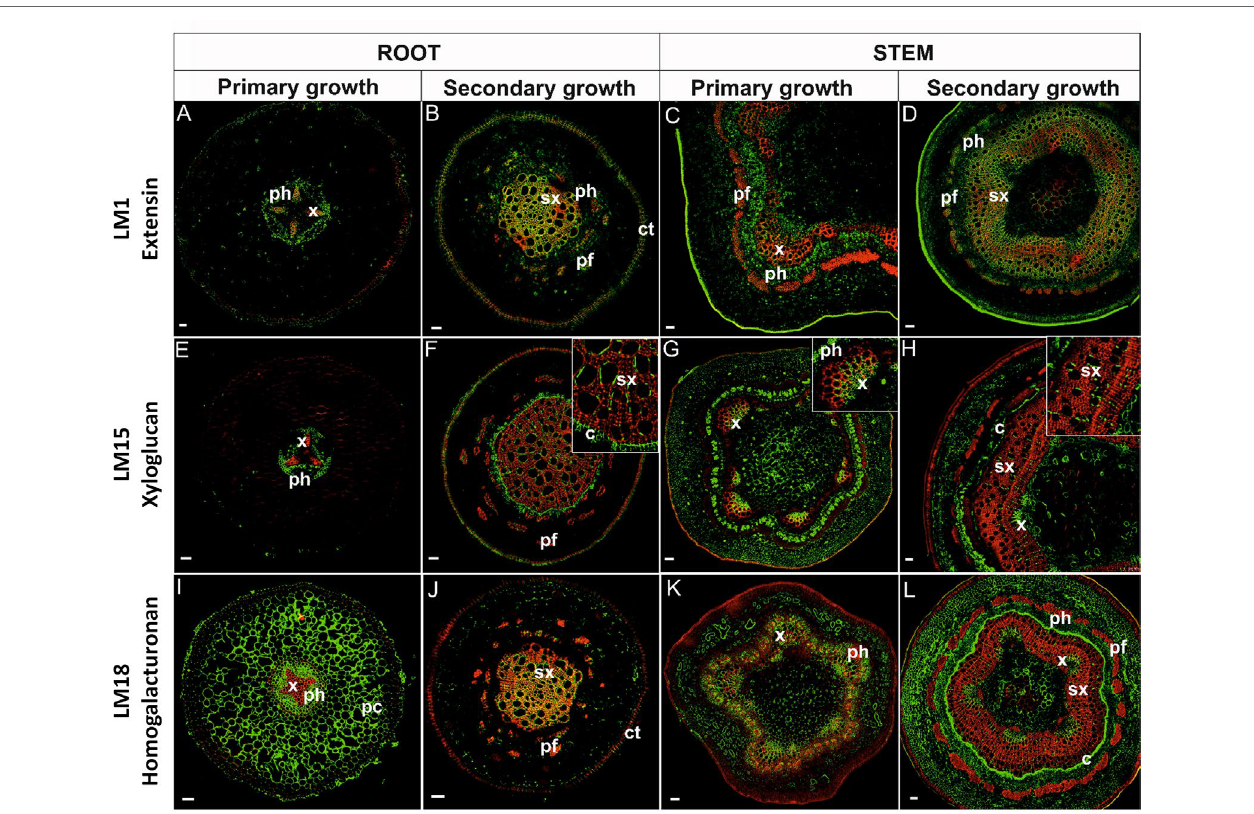
FIGURe 5 | Immunolocalization of extensins (a – D) , xyloglucan (e – h) , homogalacturonan (I – l) , and their co-localization with lignins in stems and pioneer roots during different developmental stages. [x, primary xylem; ph, phloem; sx, secondary xylem; pf, phloem fibers; c, cambium; ct, cork tissue (phellem); pc, parenchyma cortex]. Bars 50